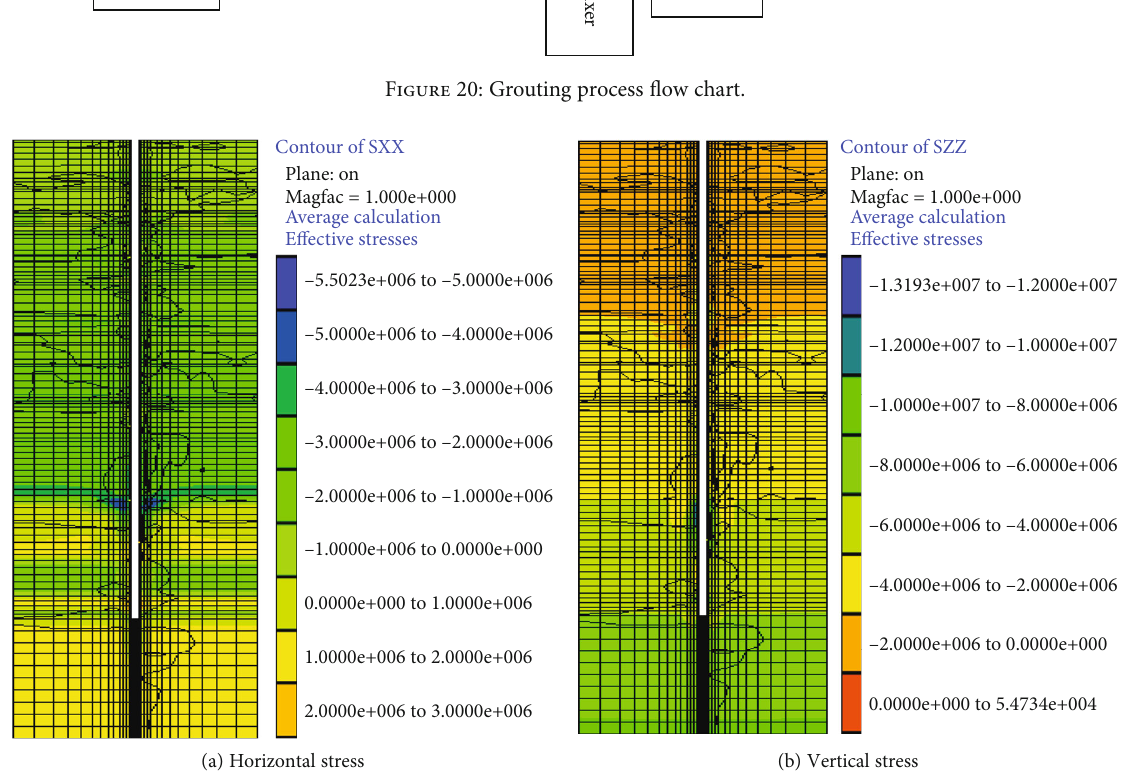
Figure 21: Shaft surrounding rock